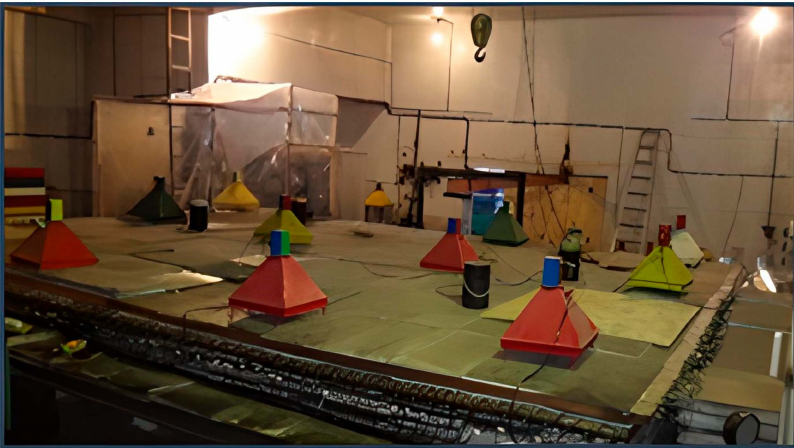
Figure 5. Gamma block with internal shower system of the SDs detectors of the ionization- neutron